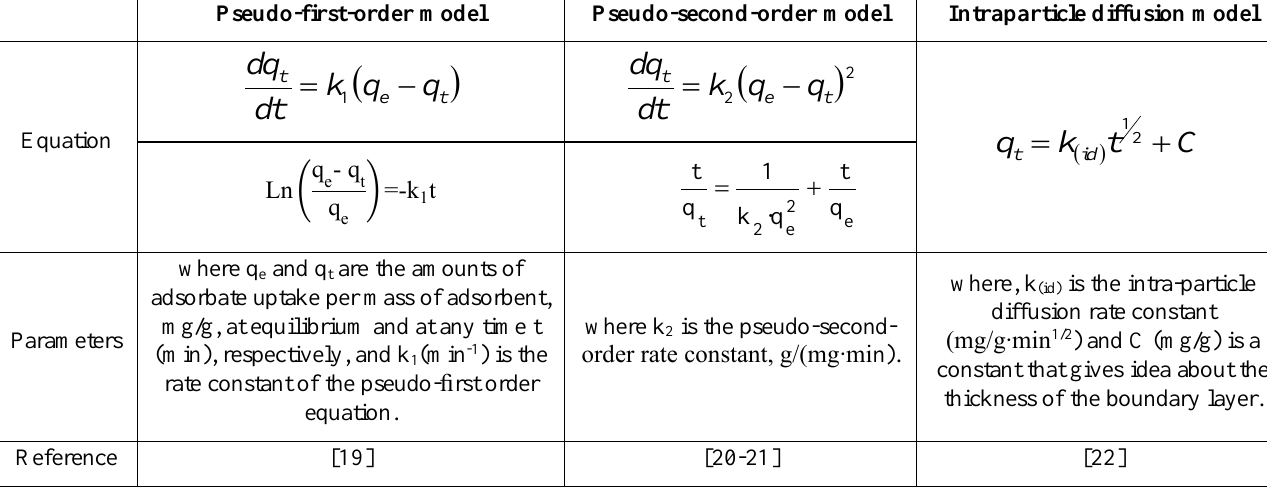
Table 2: Summary of the equations of the kinetic models applied in this work for describing phenol adsorption onto SBFA in a batch